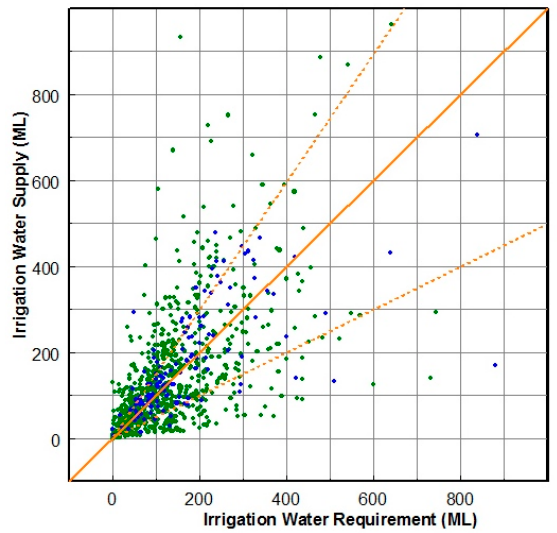
Figure 8. Regional relationship between irrigation water requirement (IWR) and irrigation water supply (IWS) at farm level during summer 2015 – 2016. Each dot represents a dairy farm. Green indicates low to medium pasture productivity (NDVI < 0.65), whereas blue indicates higher productivity (NDVI ≥ 0.65). The continuous diagonal line shows the 1:1 relationship. The two broken lines show the limit of ‘optimal’ irrigation (IWS/IWR: 0.5 – 1.5).